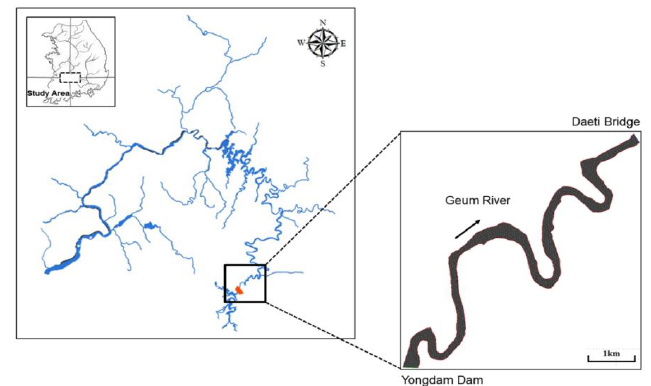
Figure 1. The study area.